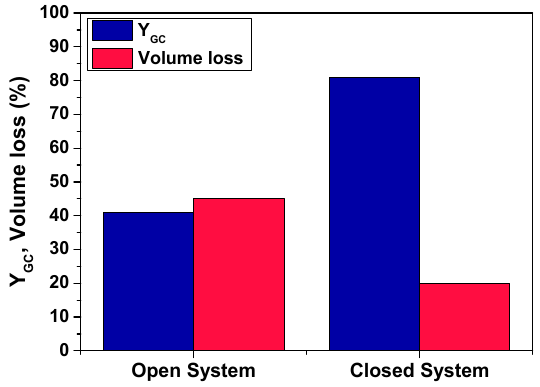
Figure 6. Yield to product and volume loss in reaction 2 using an open and a closed system with CALB as catalyst. Conditions: T = 60 °C ; DMC:Gly = 3:1; enzyme load: 3% w / w ; solvent: tert-butanol (30% v / v ) agitation speed: 400 rpm.